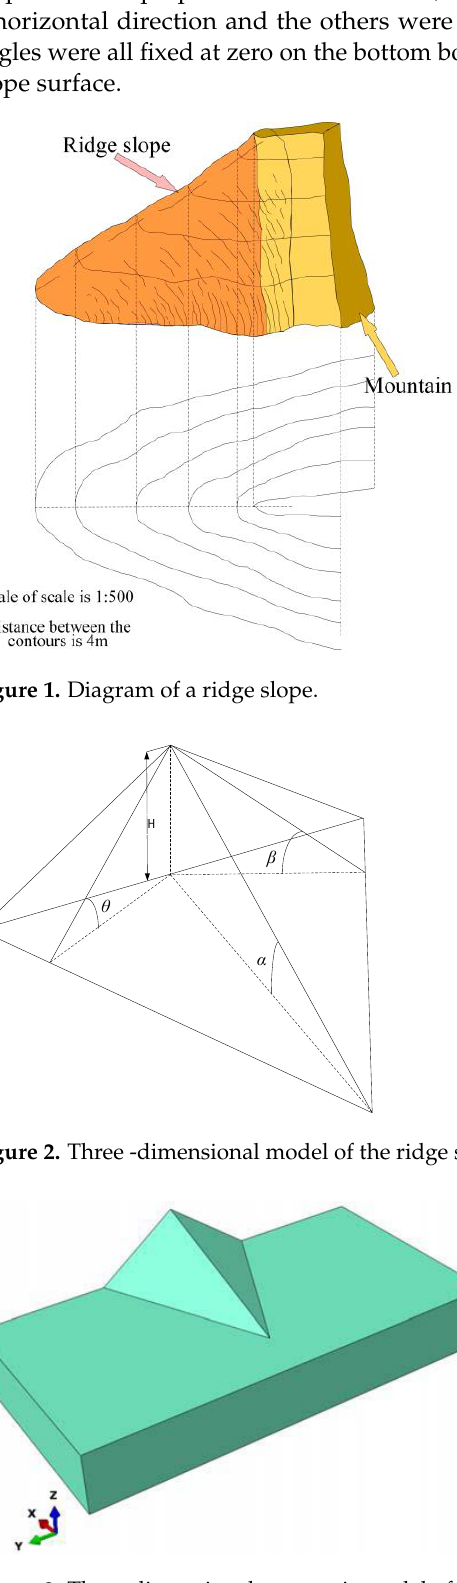
Figure 3. Three-dimensional geometric model of the ridge slope.